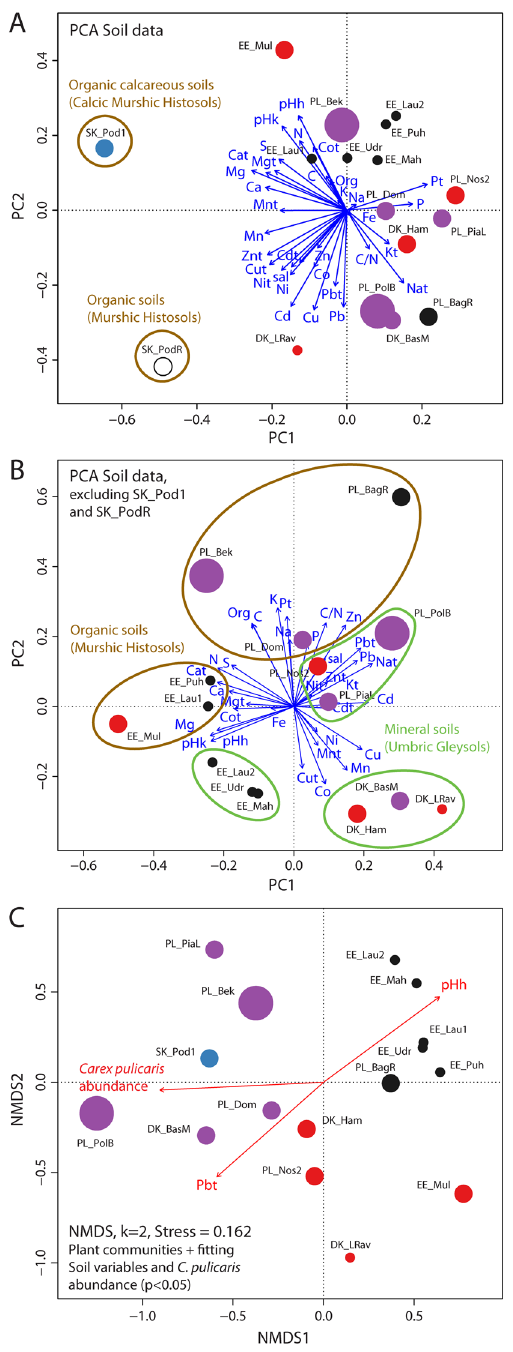
Figure 6. Ordination biplot of principal component analysis (PCA) of soil dataset. ( A ) including Slovak sites SK_Pod1 and SK_PodR and ( B ) excluding them (lower panel). Grouping circles according to classically recognised soil types; ( C ) non-metric multidimensional scaling (NMDS) of species composition data showing grouping of localities, with maximal variance explained along NMDS1 and NMDS2. Soil variables significant at p < 0.05 fitted to ordination biplot. Locality abbreviations follow Table 1. Colouring corresponds to clustering pattern, symbol size reflects Carex pulicaris abundance. Carex pulicaris abundance is not related to PCA grouping patterns (p > 0.05) but significant to plant community grouping (p < 0.05). Colouring of symbols: black—Estonian group, blue—Slovakian group, orange—Radecz group, purple—Ambiguous group, red—Polish group, white—locality in Slovakia with the occurence of C. pulicaris , but lacks species composition data. Note: Averages from three subsamples were inputs for localities SK_Pod1 and